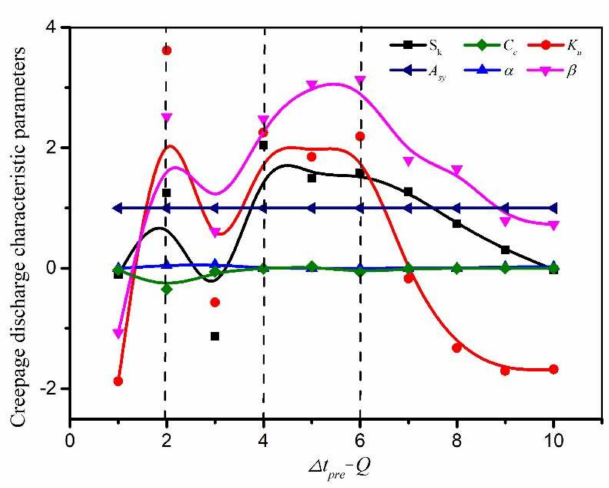
Figure 6. Variation law of characteristic parameters in the ∆ t pre -Q characteristic spectra during the entire creepage discharge development